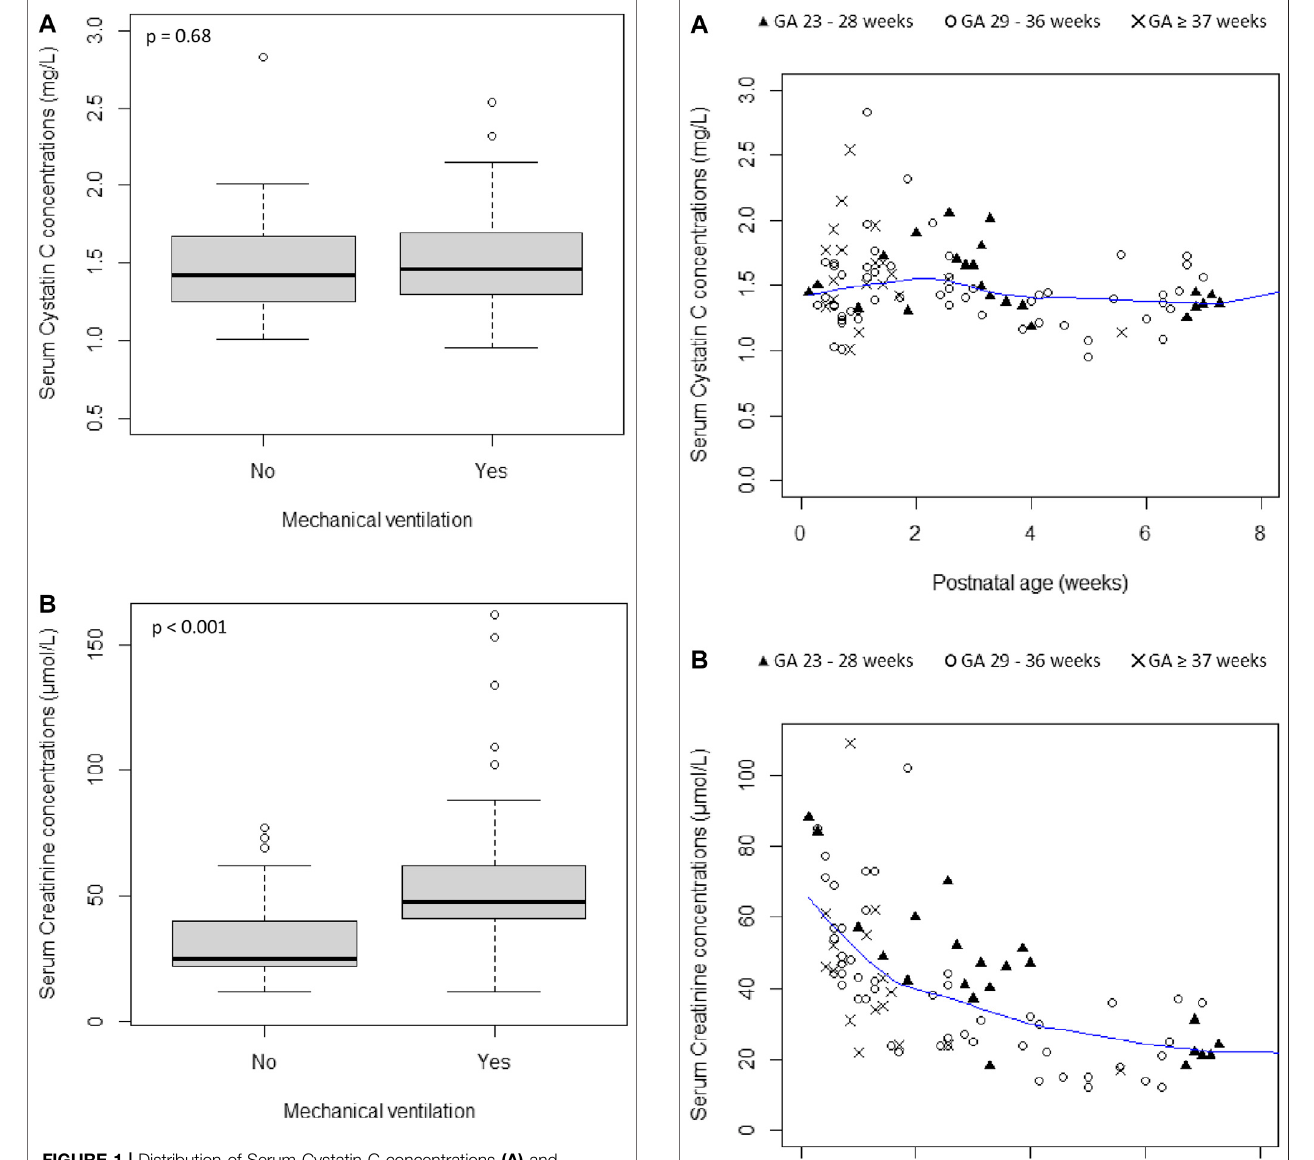
FIGURE 1 | Distribution of Serum Cystatin C concentrations (A) and Serum Creatinine concentrations (B) in patients treated with and without mechanical ventilation.